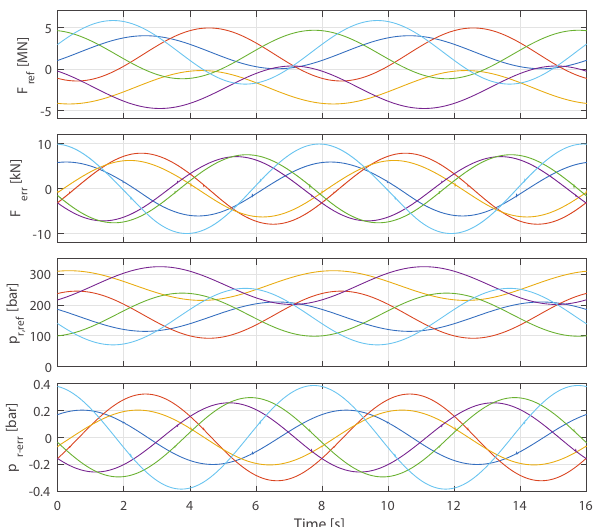
Figure 11: Simulated system response for cylinder force control using two pressure